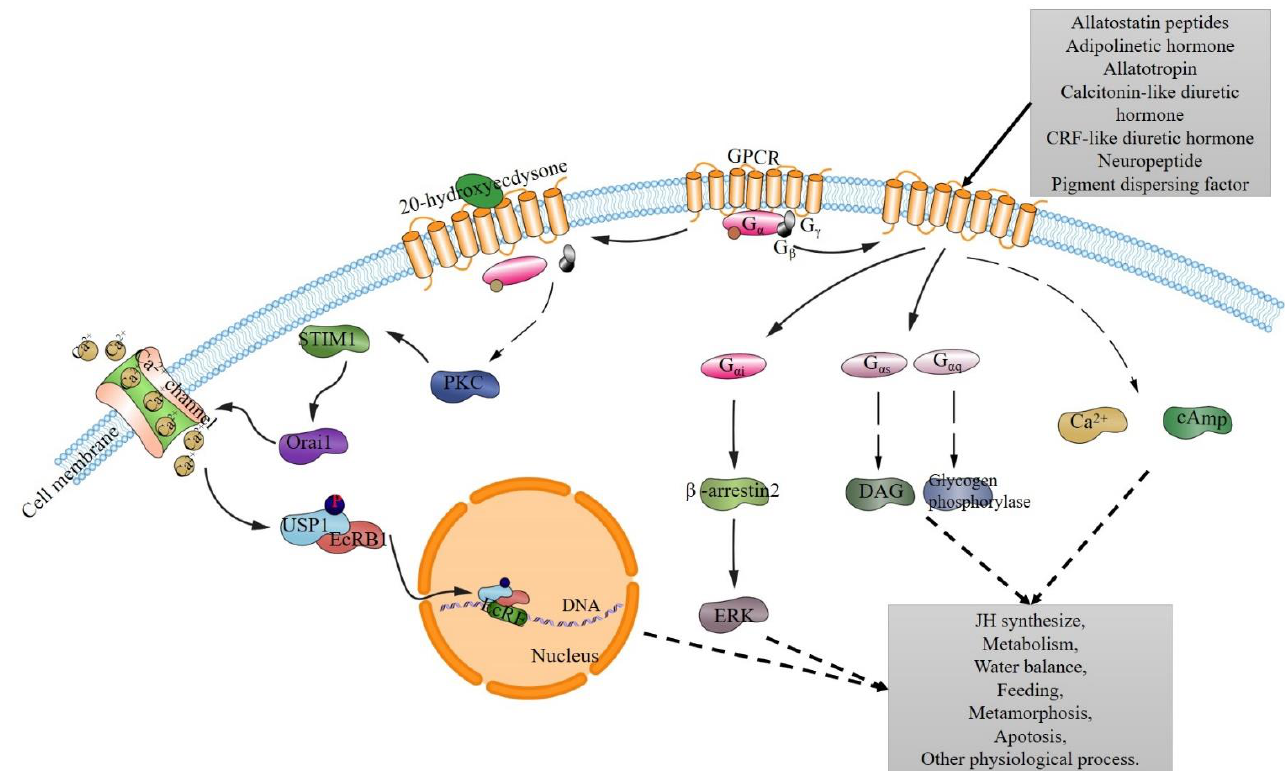
Figure 2. The proposed GPCR regulatory pathways in insect physiology processes. 20-Hydroxyecdysone interacts with GPCR to initiate 20-E signal pathway [32,47,124] and triggers protein kinase C (PKC) [124]. PKC promotes the phosphorylation of the stromal interaction molecule 1 (STIM1), causing the aggregation of STIM1 [122]. The STIM1 interacts with the calcium release-activated calcium channel protein 1 (Orai1) to induce an influx of calcium ions [47], which stimulates the phosphorylation of ubiquitin specific peptidase 1 (USP1) and forms the USP1-EcRB1 (Ecdysone receptor) complex [32,47,122], which is then transferred to the nucleus and binds to the EcRE (ecdysone response elements) site to upregulate the genes involved in the various physiological functions [32,47,122,123]. Other neuropeptides and hormones also act as the ligands acting on the GPCR pathways, such as type C allatostatin peptide, which activates AST-C receptor to activate human G α i protein and turn to activate β -arrestin2, and stimulate the activity of ERK finally [129]; adipokinetic hormone can bind with GPCR and activate G α subunits to activate the glycogen phosphorylase and DAG [83,130]; and others can also bind with GPCR to process their physiological function through the cAMP or Ca 2+ channel activation [67,83,126,131–135].